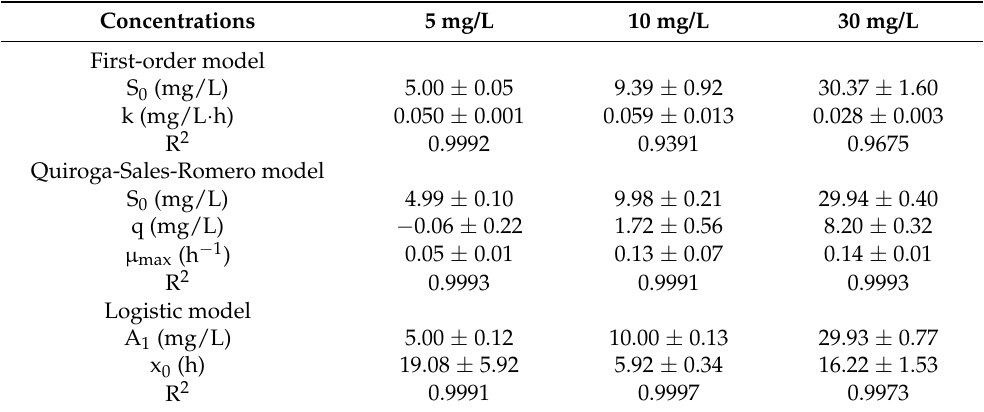
Table 1. The kinetic parameters corresponding to the degradation curve by a mixed consortium at various concentrations.